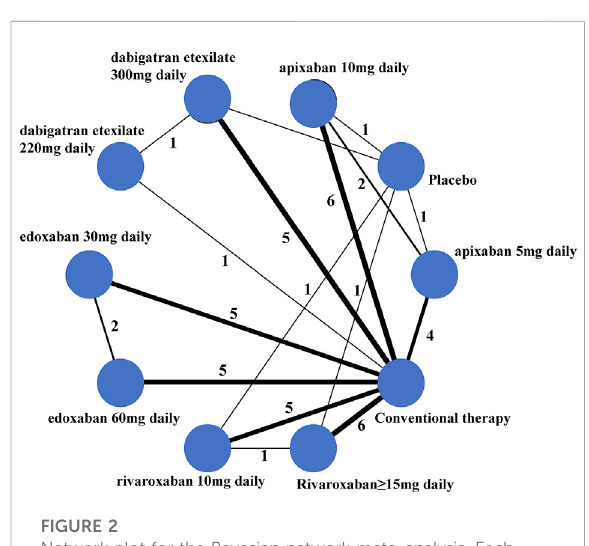
FIGURE 2 Network plot for the Bayesian network meta-analysis. Each noderepresents aregimen,thelinesbetween thenodesrepresent the head-to-head comparisons, the thickness of the lines represents the number of studies, and the number of studies is marked